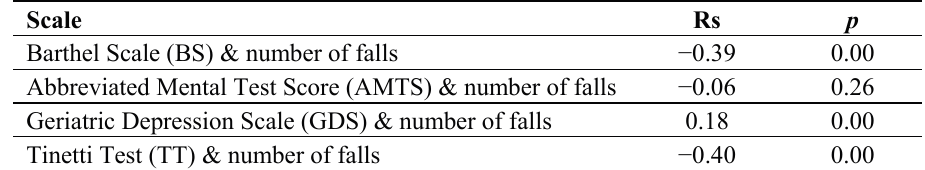
Table 7. The correlation between the number of falls and the results of the Barthel Scale (BS), Abbreviated Mental Test Score (AMTS), Geriatric Depression Scale (GDS) and Tinetti Test (TT) (Spearman’s rank correlation coefficient).